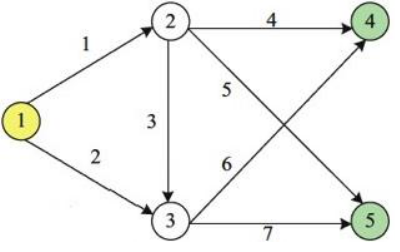
Figure 2. A toy example with 5 nodes and 7 links. Table 1. O-D trips, routes and route links in the Figure 2 example.